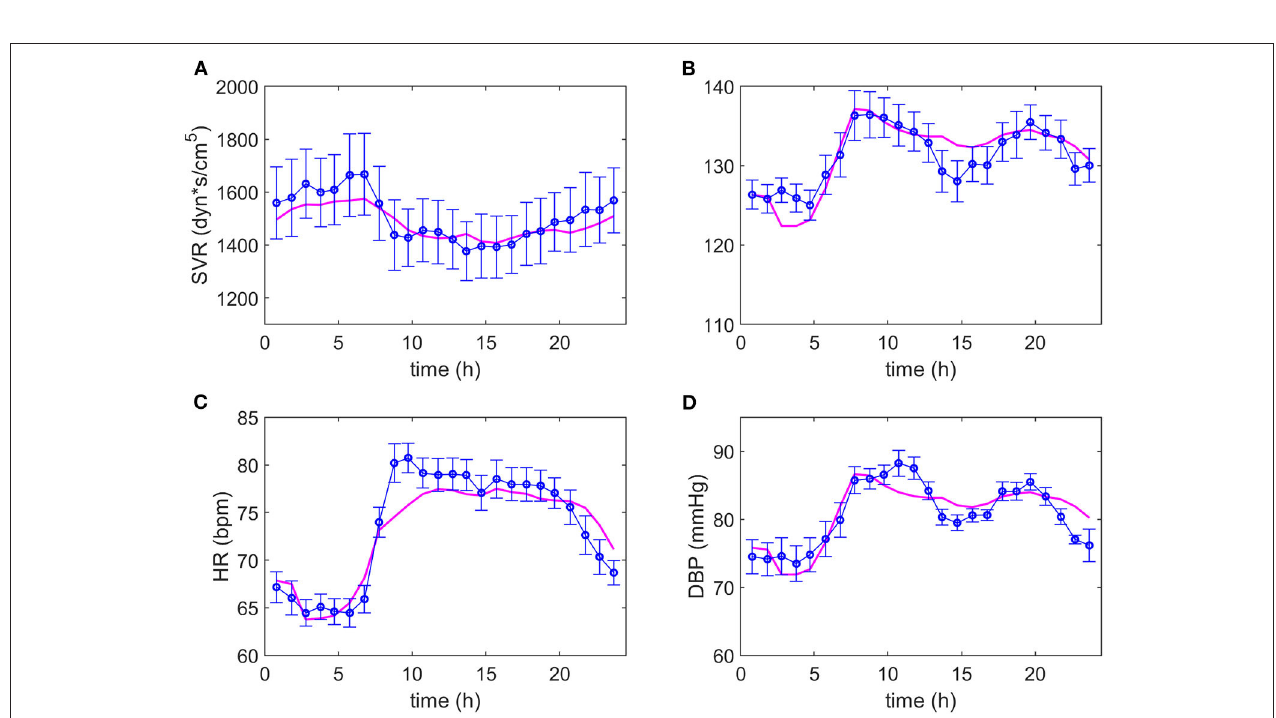
FIGURE 3 | Adjustment of the model to the experimental data of non-dipper subjects. The magenta line represents the values predicted by the model and the blue line and markers, the experimental data with their respective standard deviations. Dynamics of systemic vascular resistance (SVR), systolic blood pressure (SBP), heart rate (HR) and diastolic blood pressure (DBP) are presented in (A–D) , respectively.